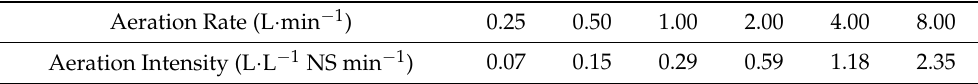
Table 2. The conversion of aeration rate to aeration intensity.